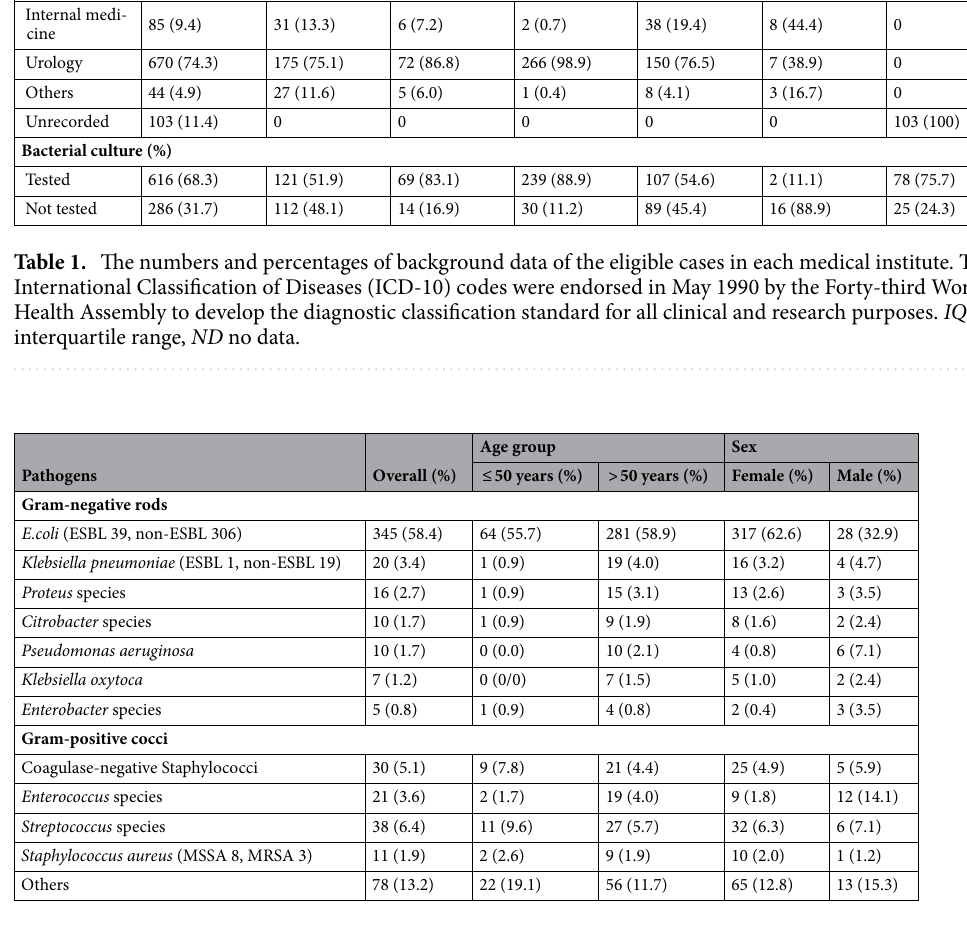
Table 2. Breakdown list of the isolated pathogens. ESBL extended-spectrum beta-lactamases, MSSA methicillin-sensitive S. aureus , MRSA methicillin-resistant S.